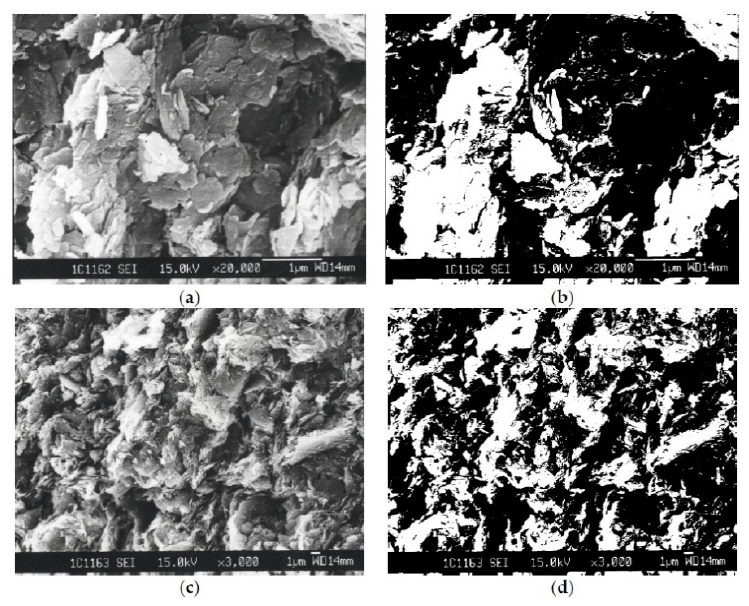
Figure 3. Image of mesoscopic parameter extraction: ( a ) 20,000× image before binarization; ( b ) 20,000× image after binarization; ( c ) 3000× image before binarization; ( d ) 3000× image after binarization.